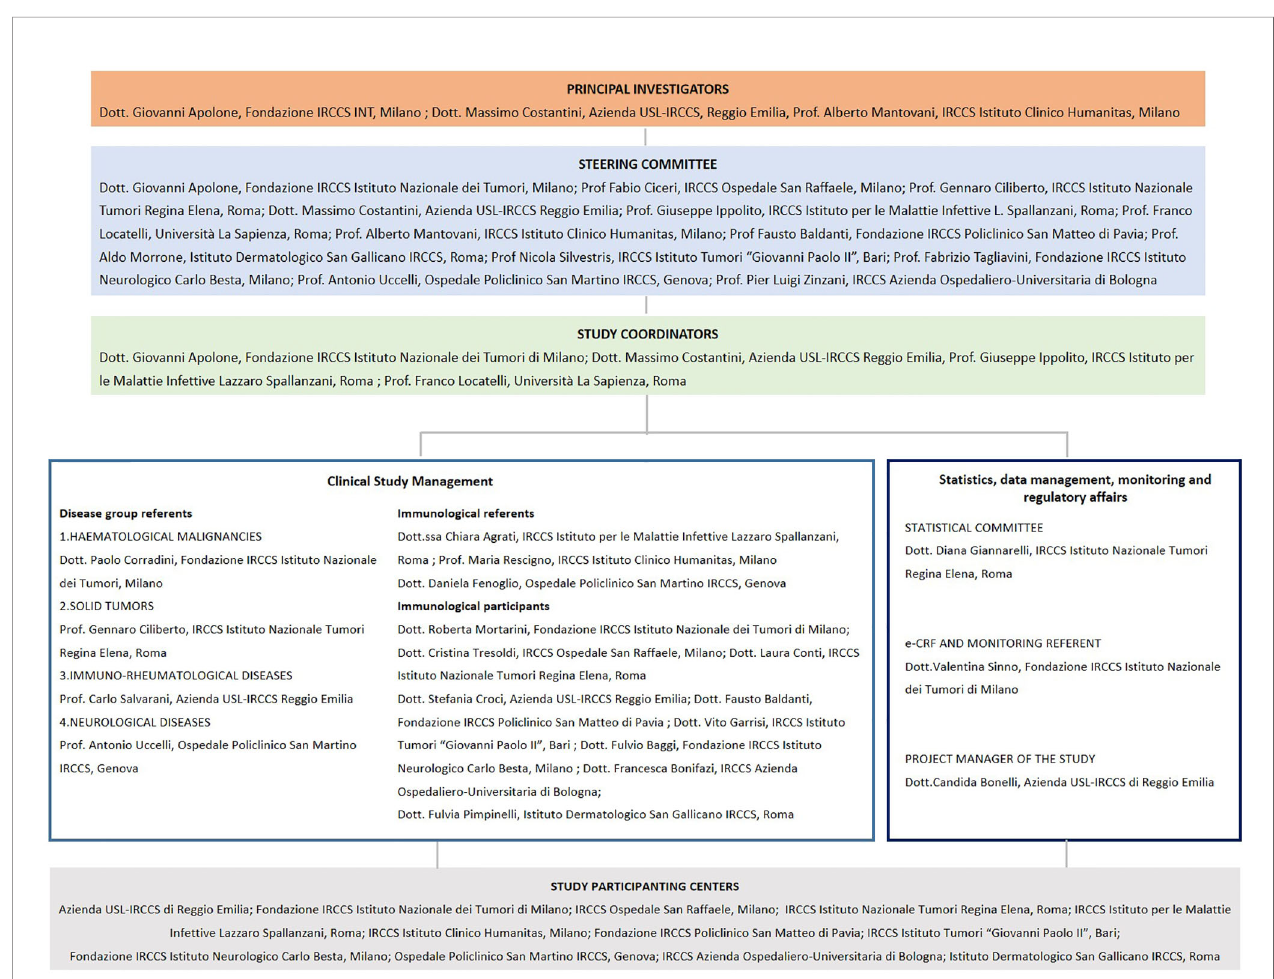
FIGURE 1 | Organogram of the clinical